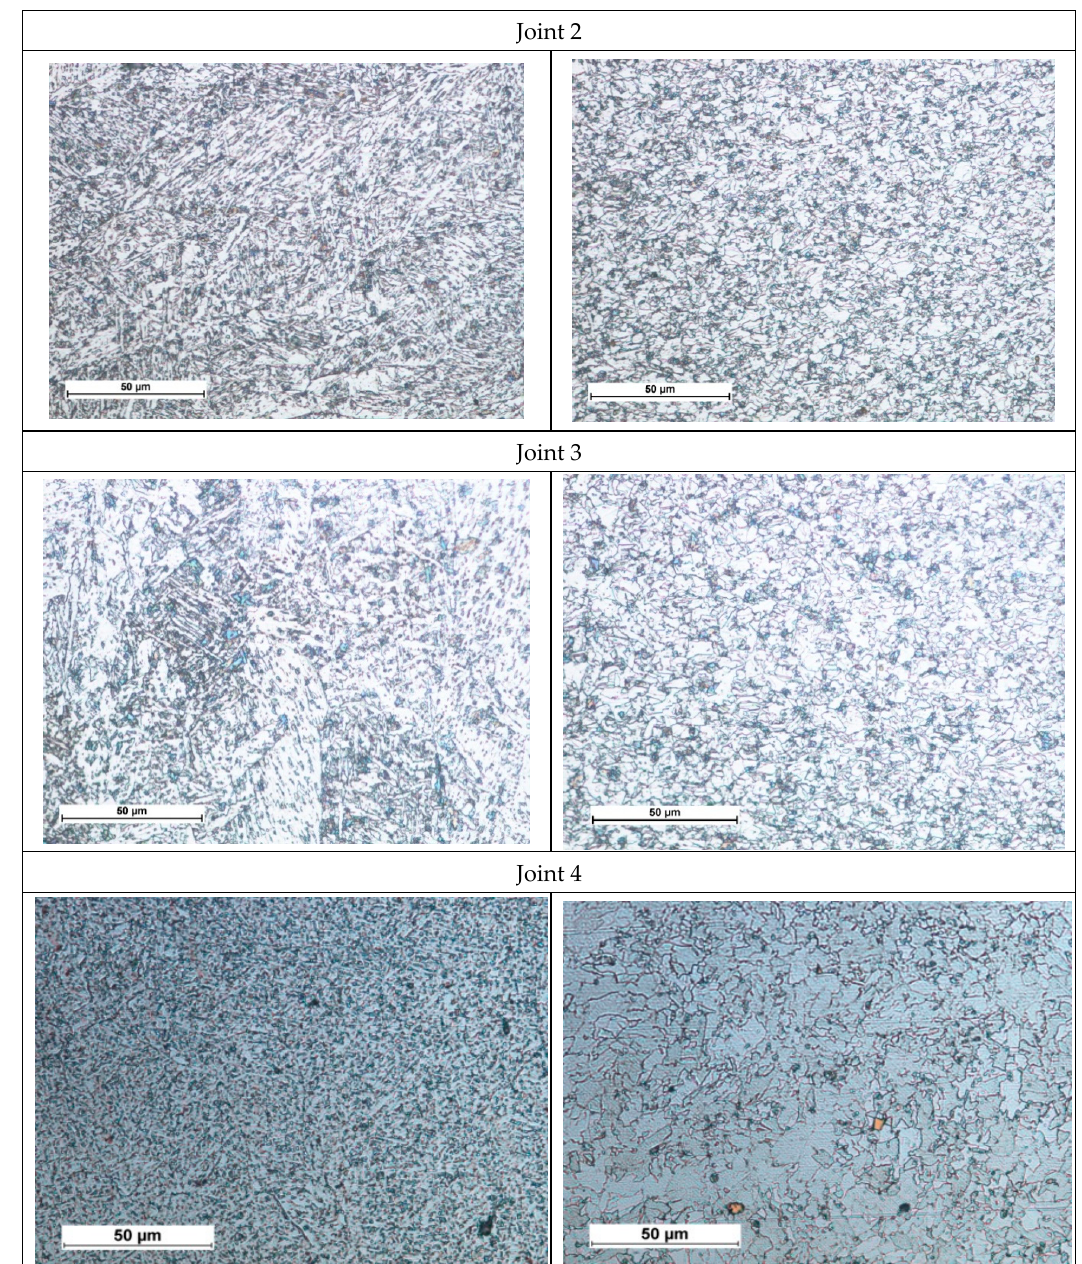
Figure 10. Middle part microstructure of S700MC steel laser and MAG welded joints.